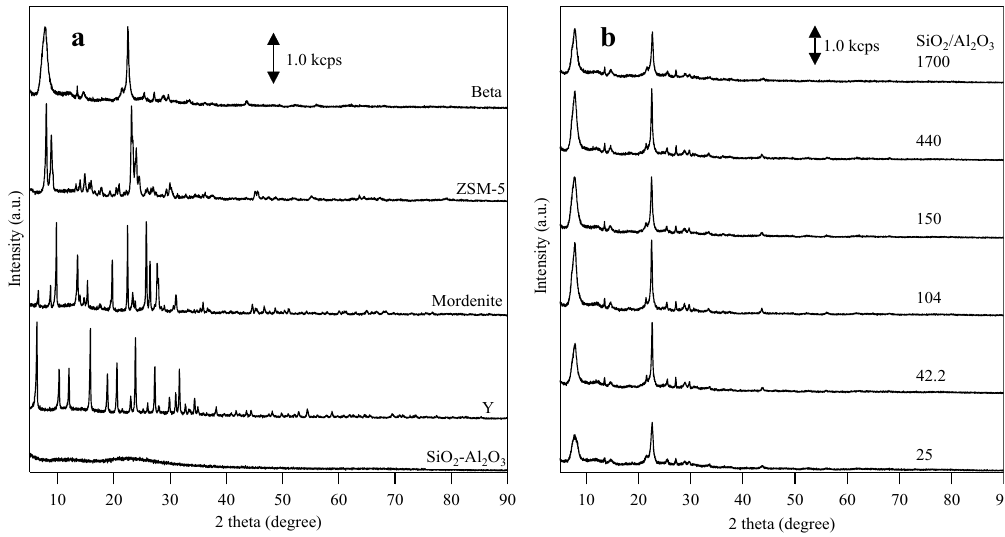
Figure 1. X-ray diffraction (XRD) patterns of ( a ) four types of reference zeolites and normal SiO 2 -Al 2 O 3 and ( b ) zeolite beta samples composed with various SiO 2 /Al 2 O 3 ratios.